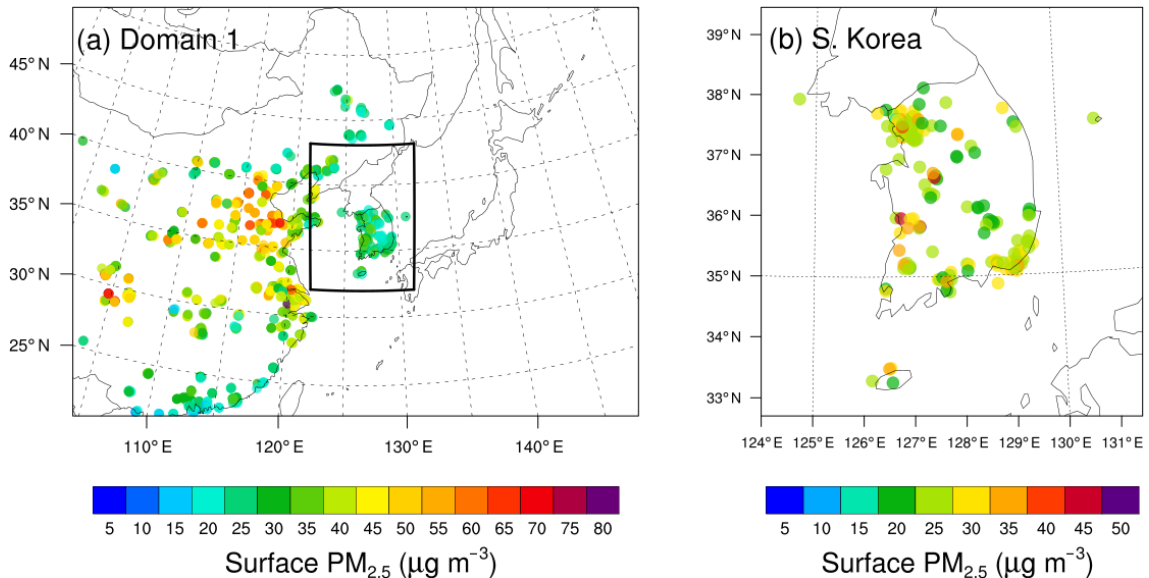
Figure 1. Surface observation network with 960 Chinese stations and 361 Korean stations in domain 1 (a) and zoomed in over South Korea in (b) . A black box in (a) indicates domain 2 over the Korean Peninsula. Dots indicate surface PM 2 . 5 observations averaged over the month of May